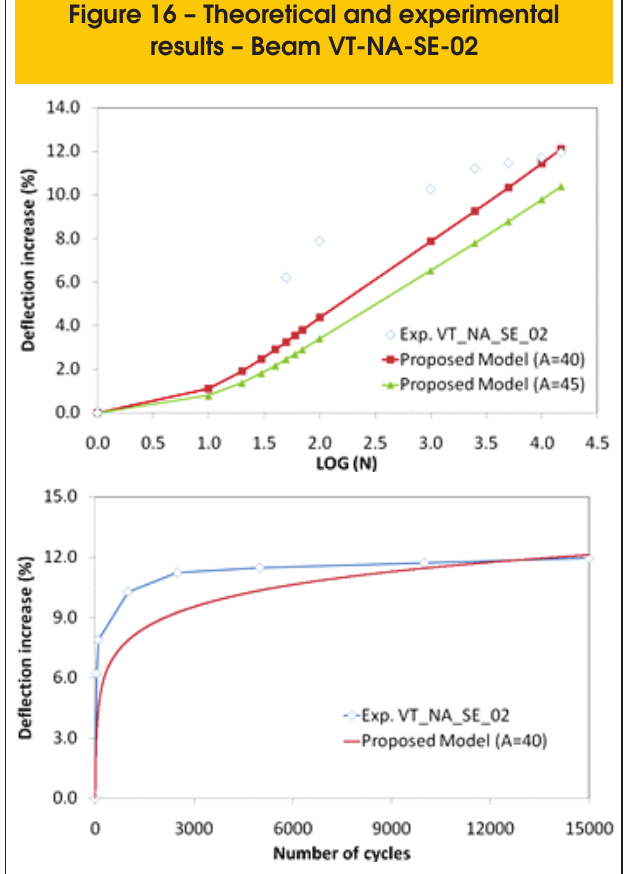
Figure 16 – Theoretical and experimental results – Beam VT-NA-SE-02